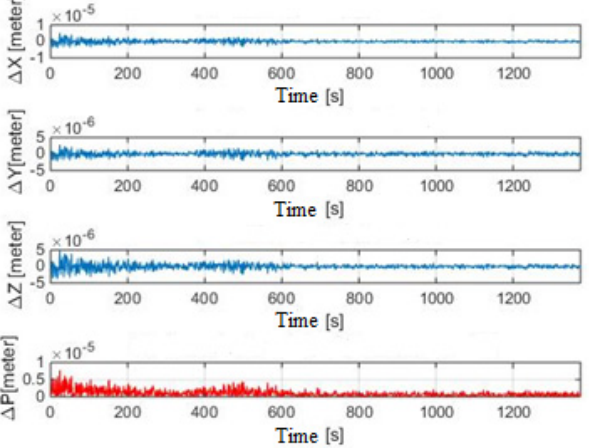
Figure 5. Coordinate determination errors ∆ X, ∆ Y, ∆ Z , and position ∆ P, straight flight.